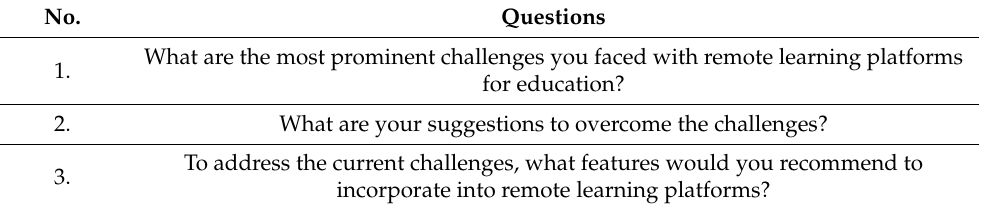
Table 1. Selected Questions of the